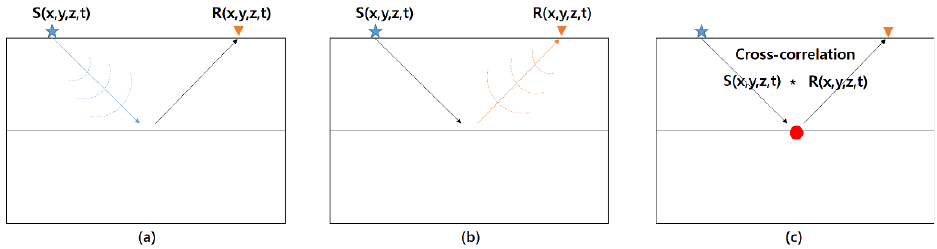
Figure 2. Schematic diagram of reverse time migration: ( a ) Source wavefield propagation at source and receiver locations indicated by blue star and orange triangle; ( b ) receiver wavefield propagation; and ( c ) seafloor reflection point (red circle) constructed from a cross-correlation (indicated by *) between the source and receiver wavefield.